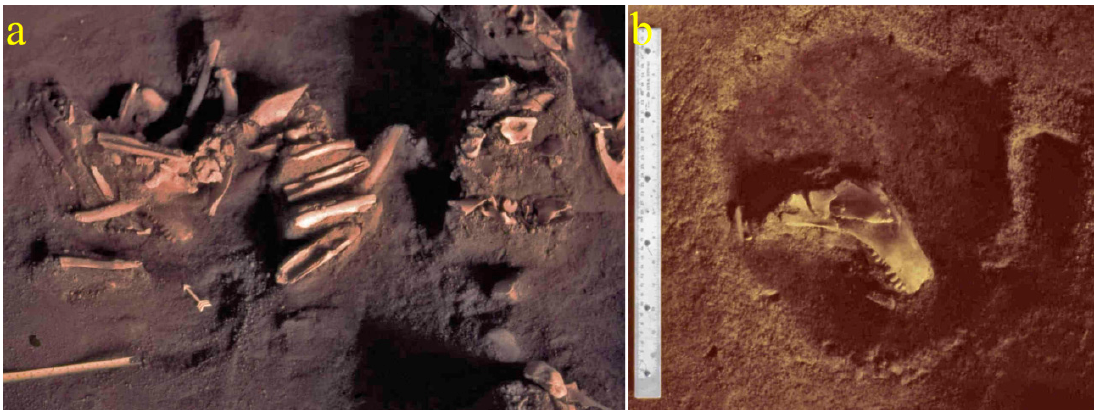
Figure 9. Images of a pile of bones placed ( a ) over a typical PA hearth with a concave base and a mandible of an infant horse placed on it ( b ).